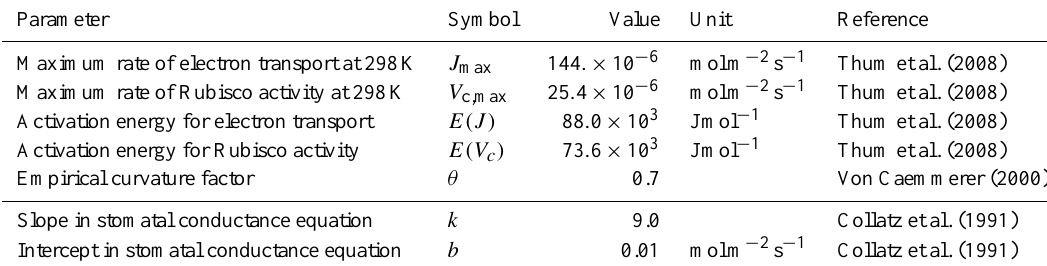
Table 1. Parameter values for the photosynthesis-stomatal conductance model. Parameter